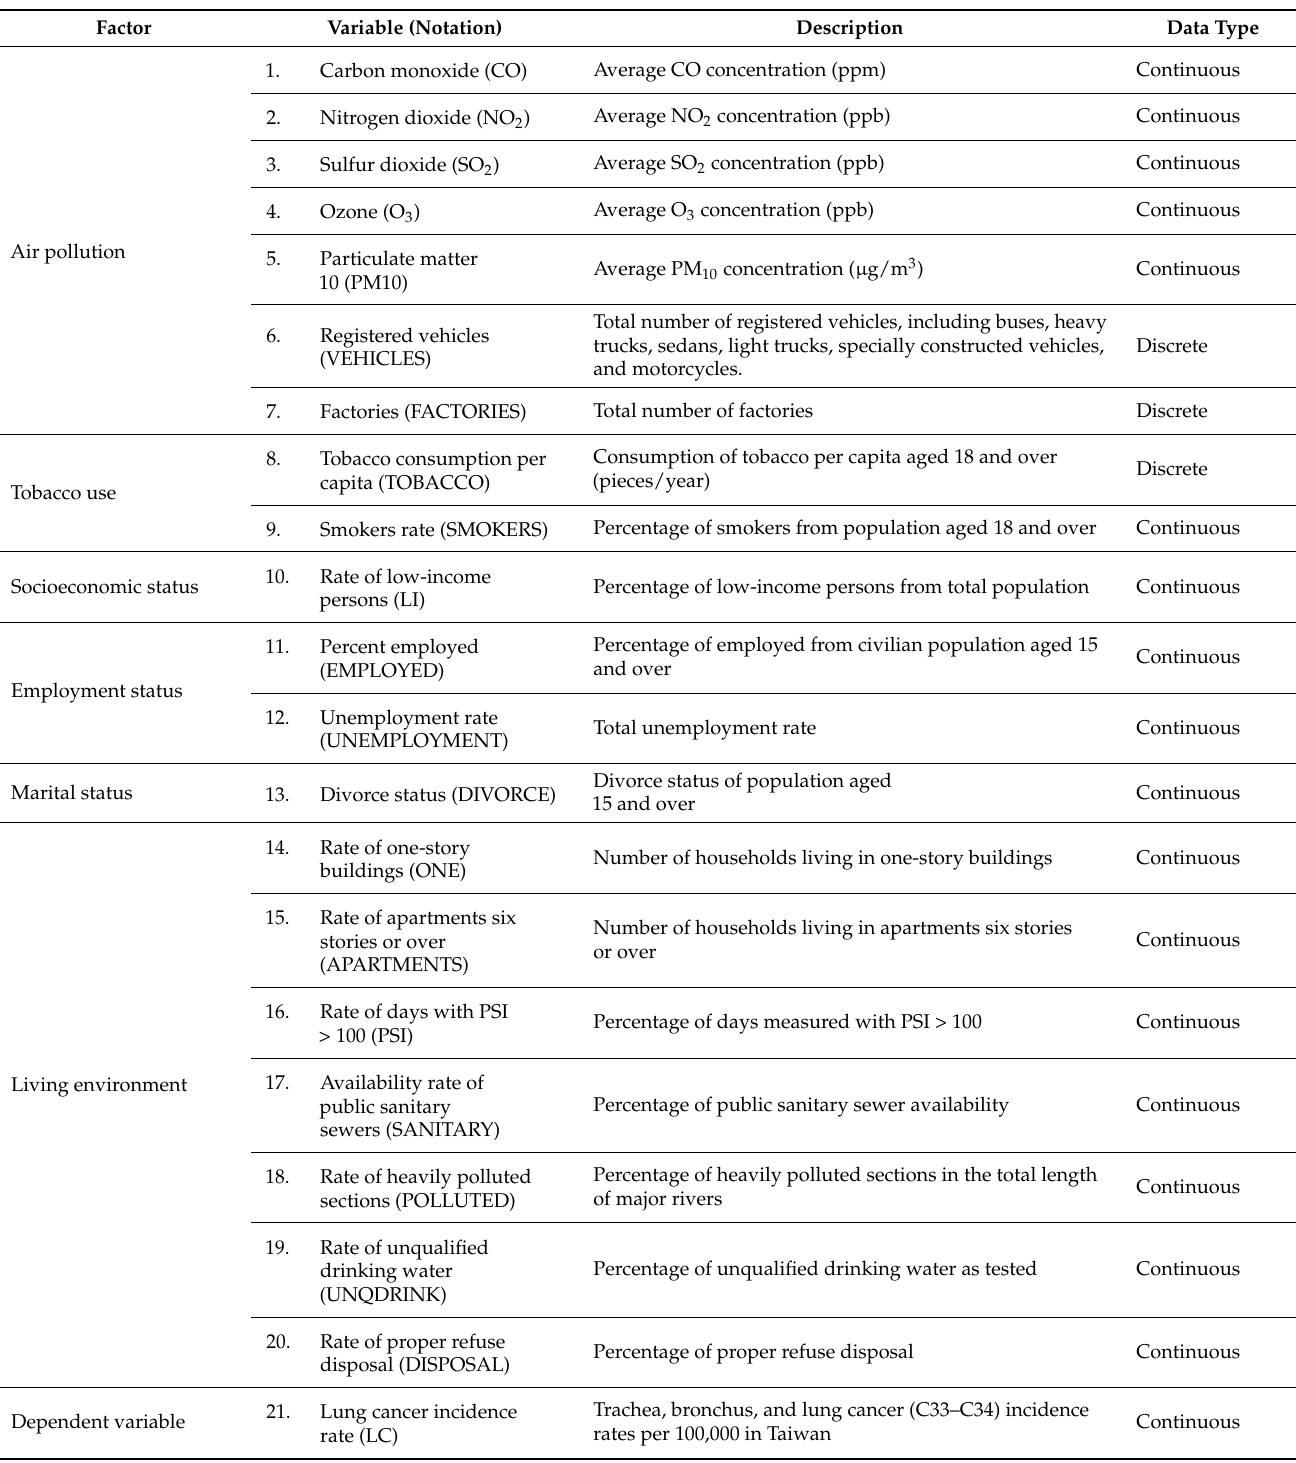
Table 1. Description of the predictive model